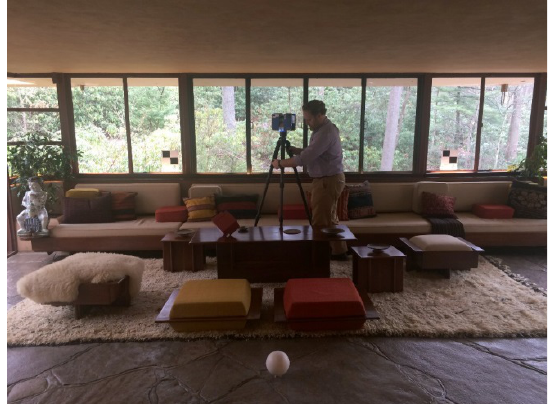
Figure 7. Scanning of the interior of